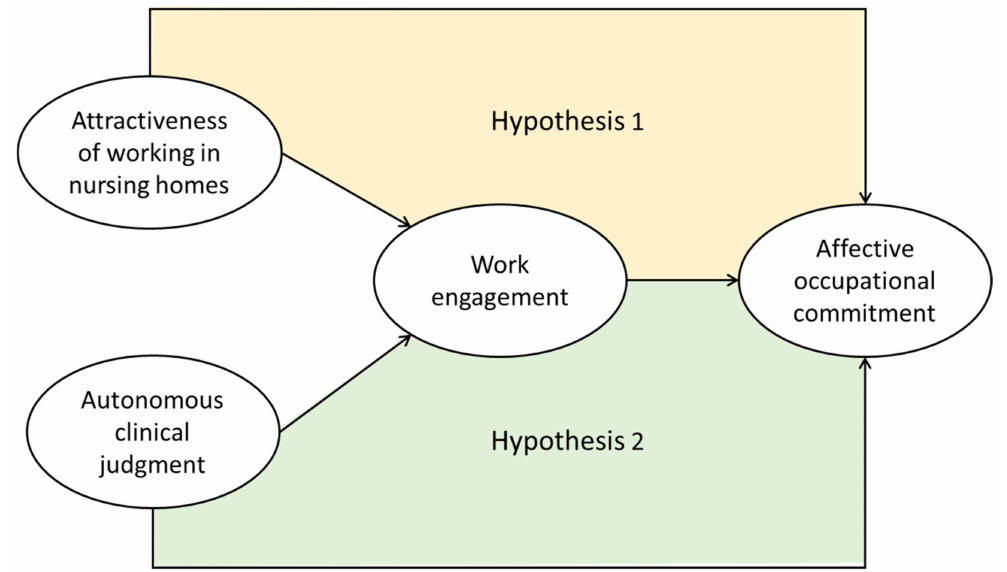
Figure 1. Motivational process model for nurses working in nursing